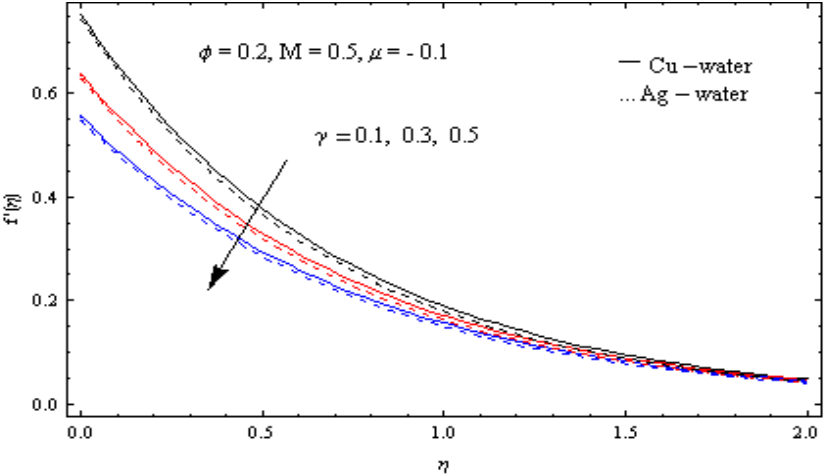
φ on skin friction coefficient in the presence of second slip. Figure 2. Effects of